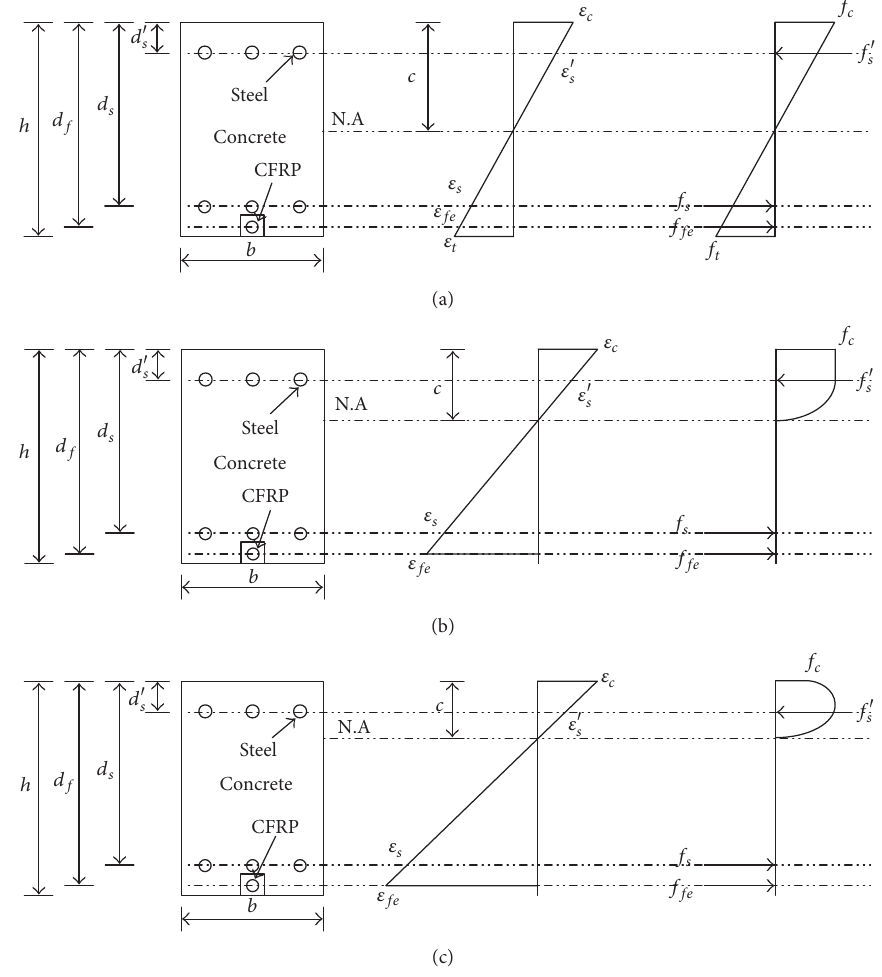
Figure 6: Strain and stress distributions per analysis